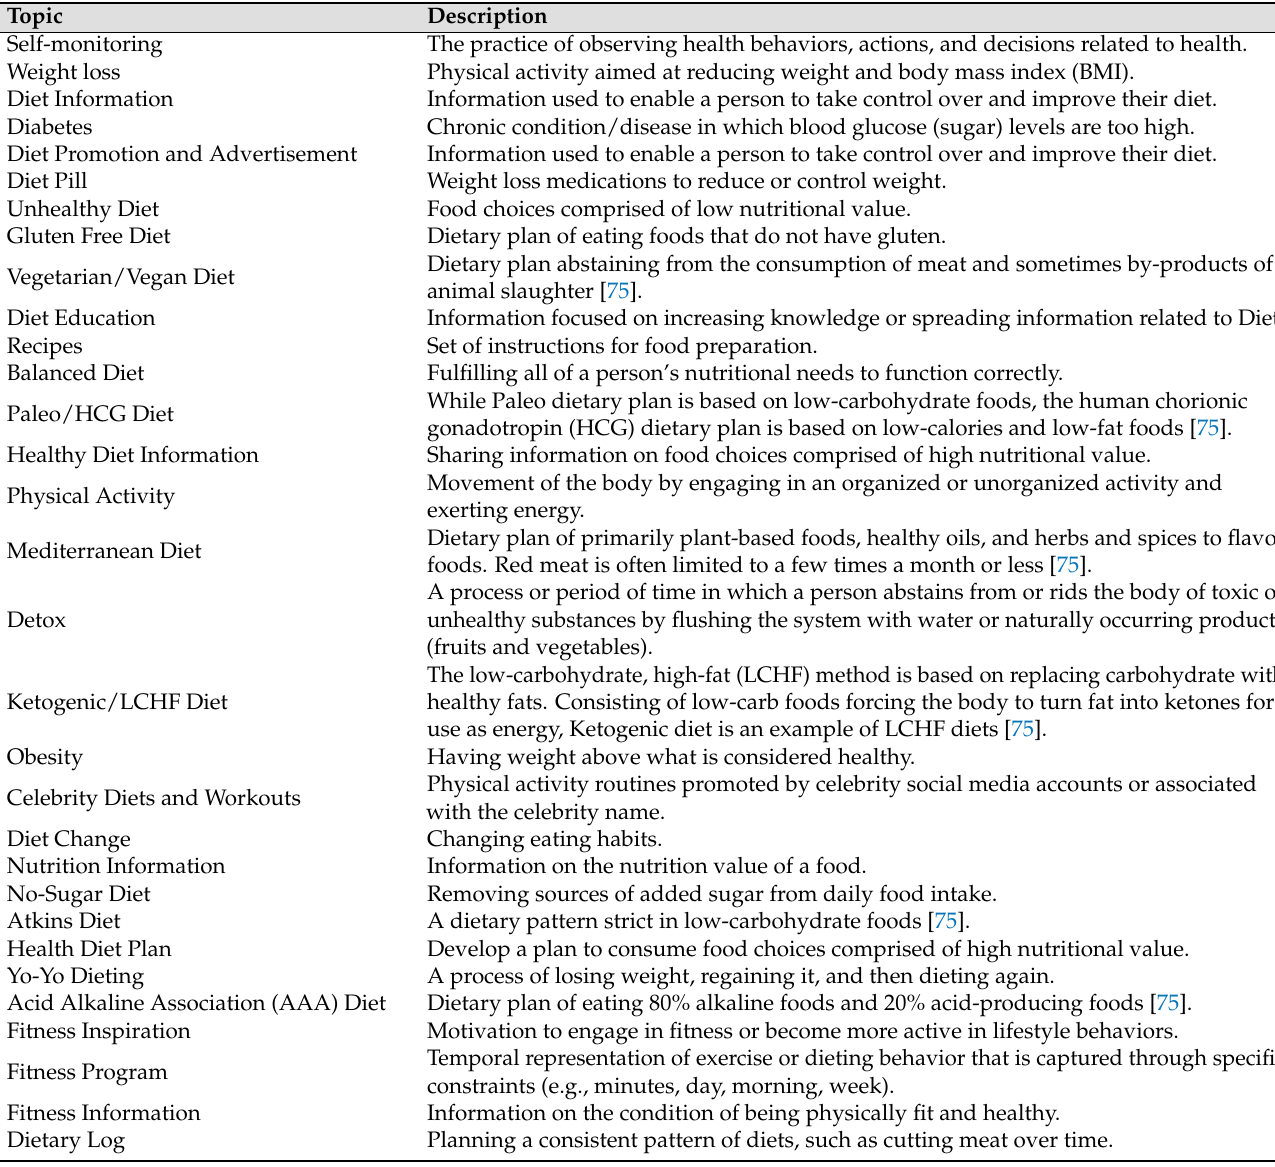
Table A1. Definition of topics by independent reviewers after reviewing the top words per